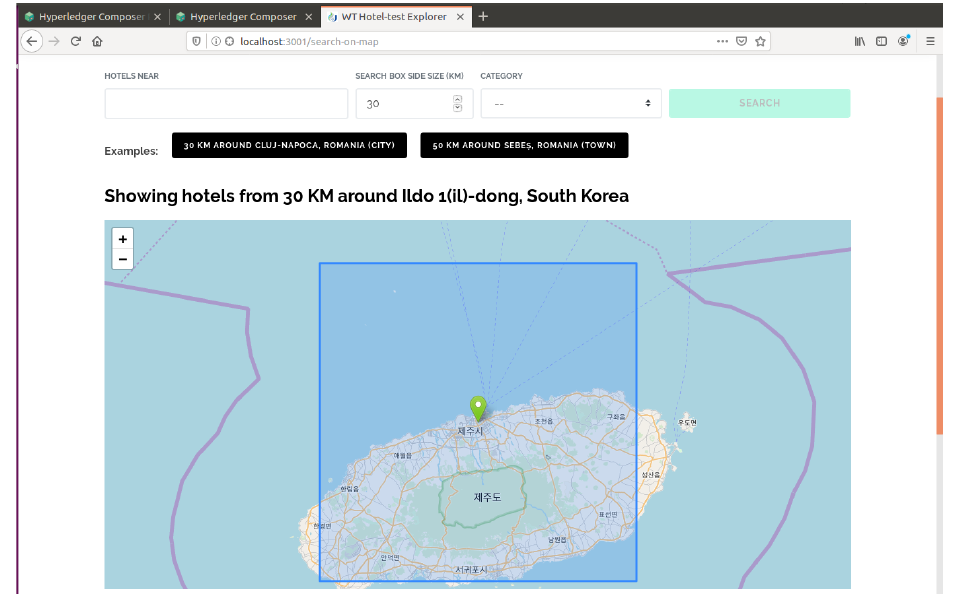
Figure 24. Network Client Map Search Implementation.